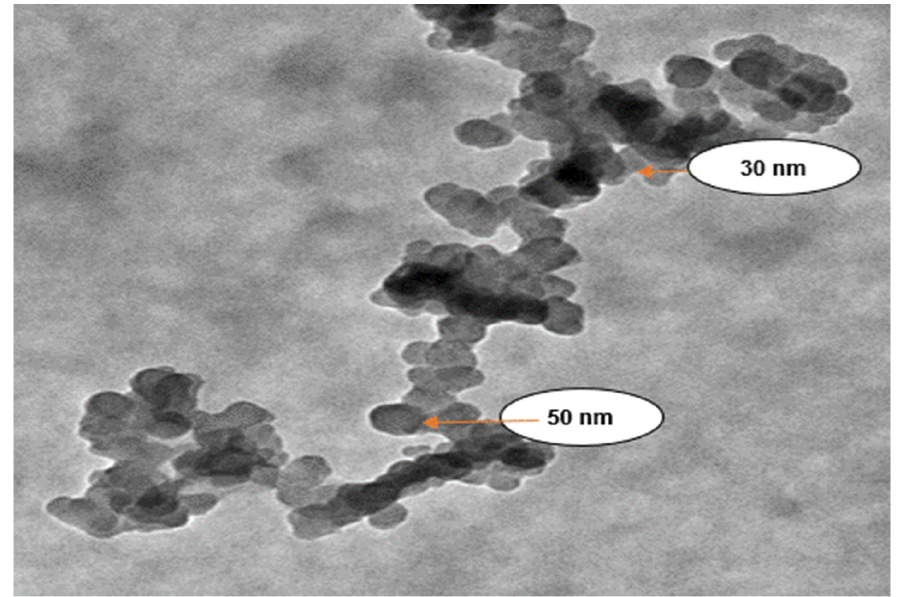
Figure 6. A TEM micrograph of synthesized